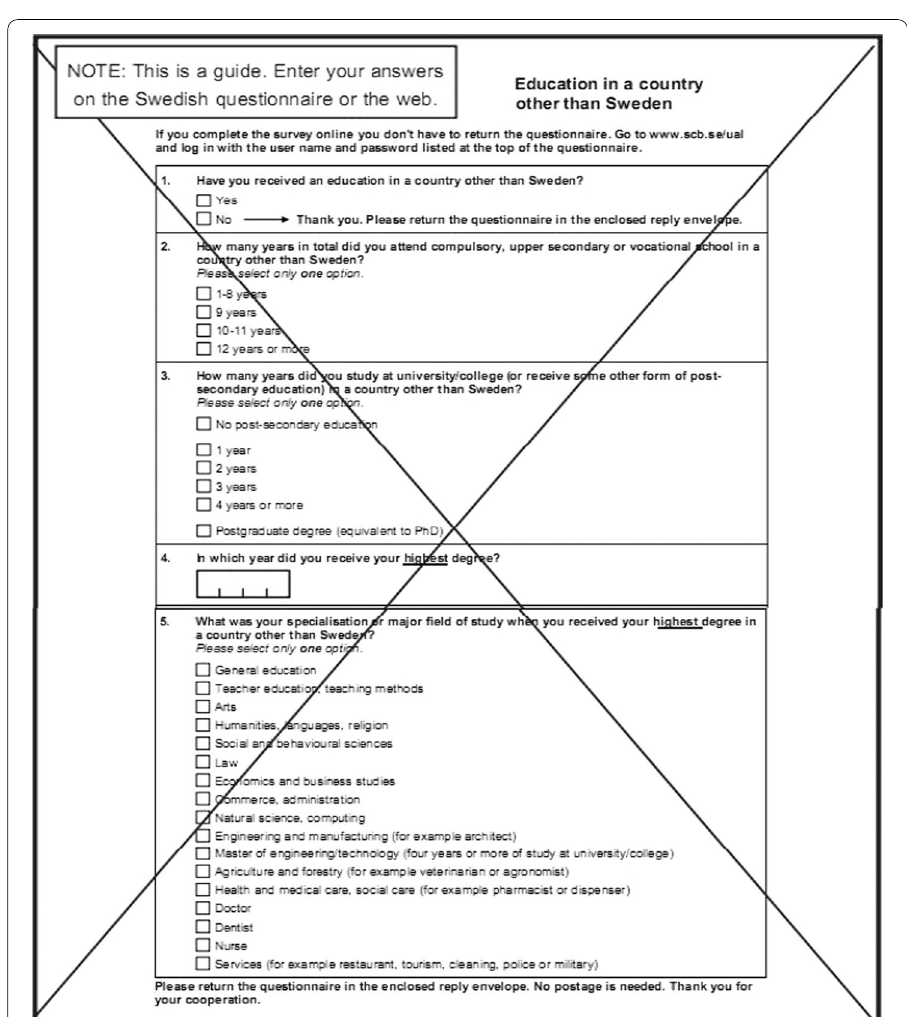
Fig. 7 Questions and answers categories in the survey of the foreign-born. Source: Statistics Sweden